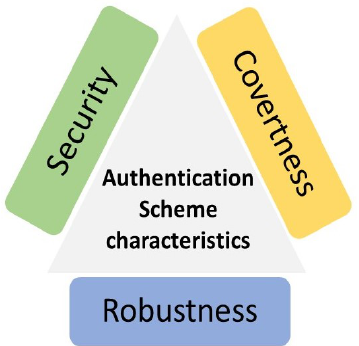
Figure 2. Authentication Scheme